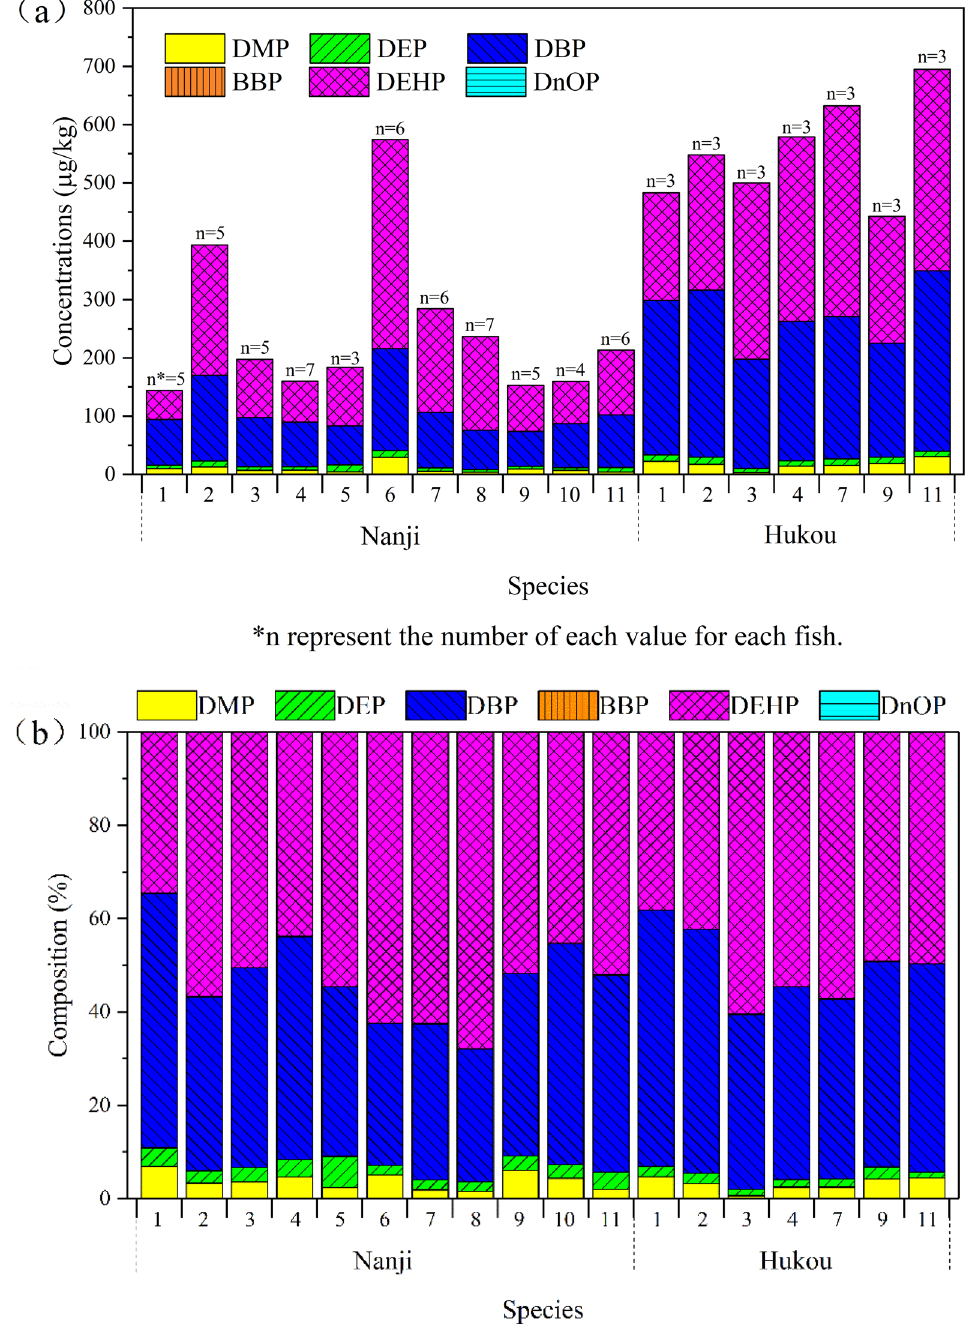
Fig. 2 Concentration ( a ) and composition ( b ) of six phthalate esters in the aquatic organisms in Poyang Lake. In order, the numbers 1 to 11 represent grass carp, crucian, silver carp, bighead carp, sharpbelly, banded catfish, catfish, Chinese perch, carp, snakehead, and topmouth